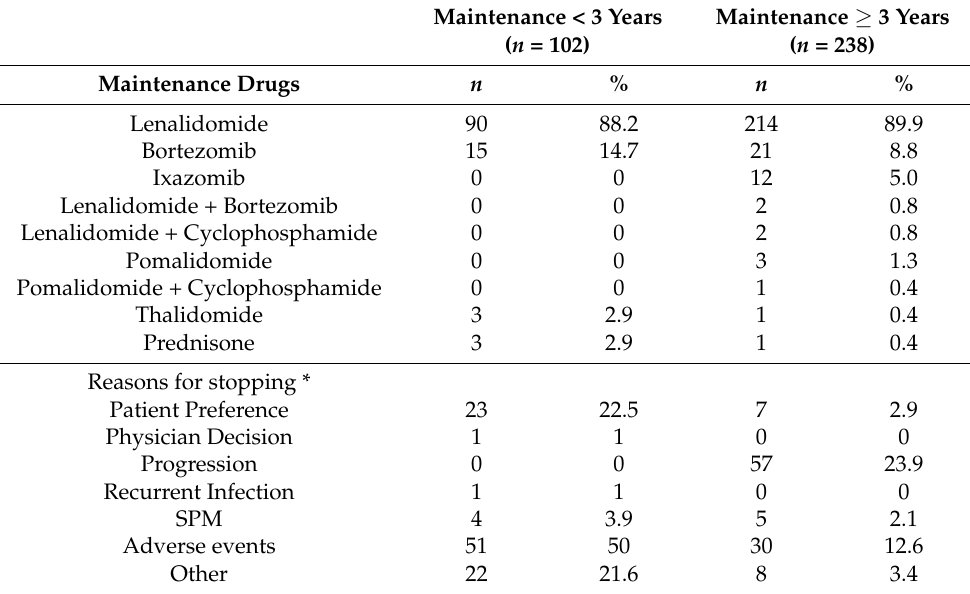
Table 2. Maintenance regimens and reasons for stopping maintenance